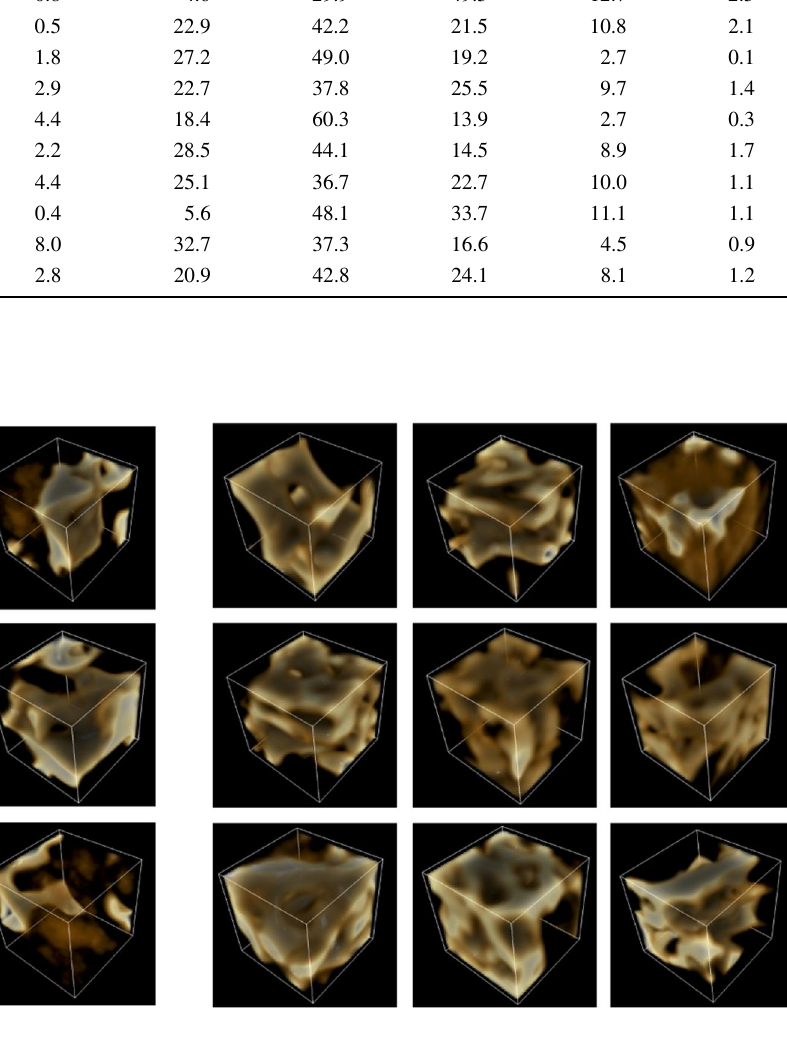
Fig. 8 Examples of class 1 subblocks Fig. 9 Examples of class 2